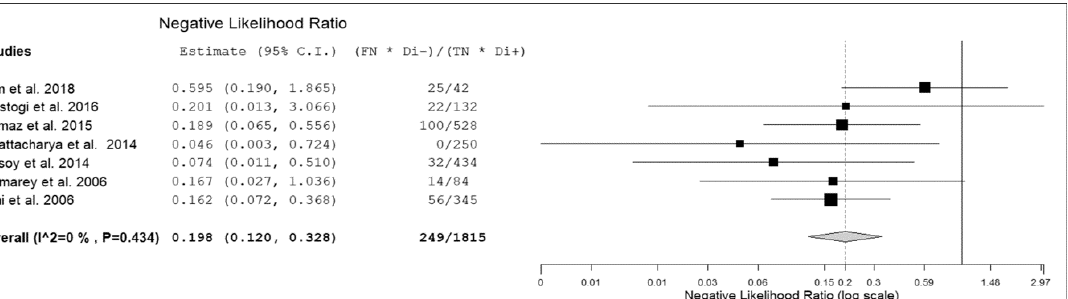
Figure 3. Forest plot of individual studies and pooled positive likelihood ratio of 18 F-FDG-WBC PET or PET/CT in patients with suspicious infectious diseases, including 95% confidence interval (95% CI). The size of the squares indicates the weight of each study.